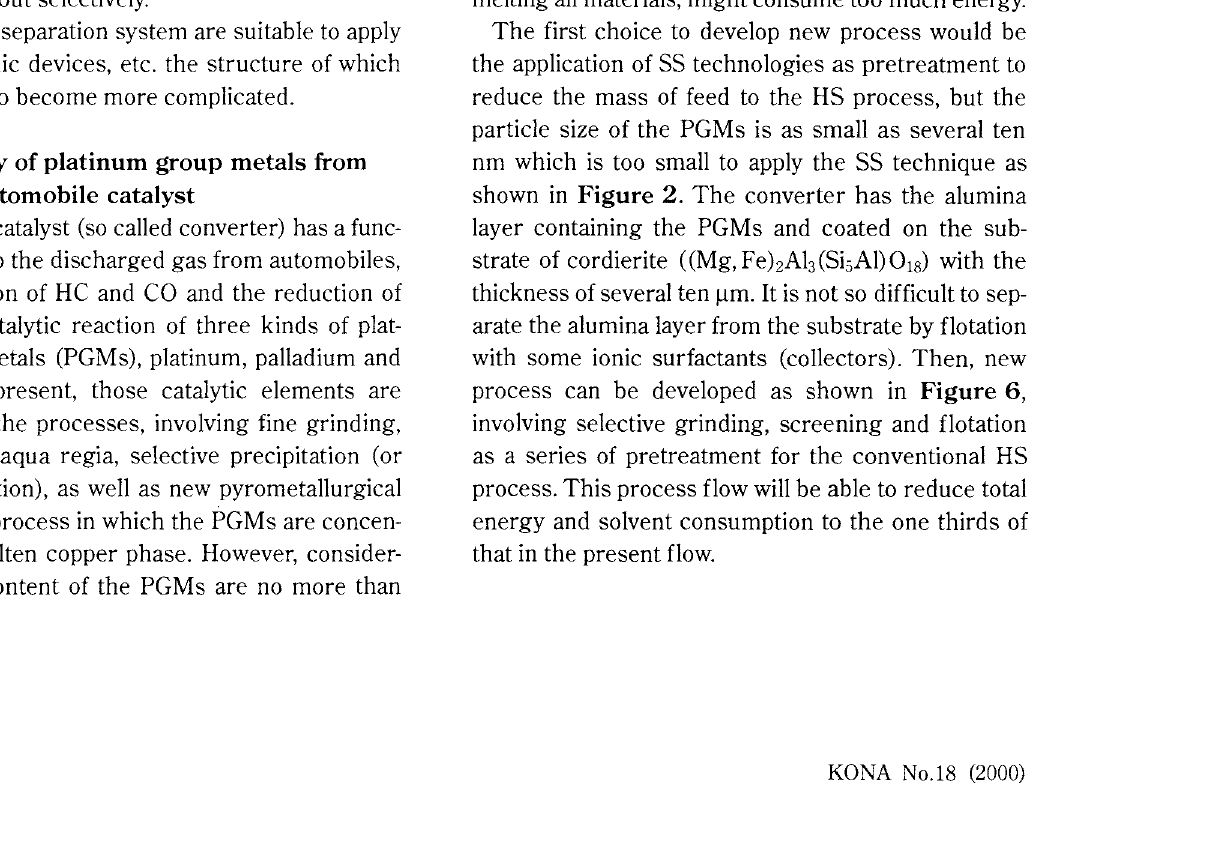
1 ppm in the converter, the process, leaching and/